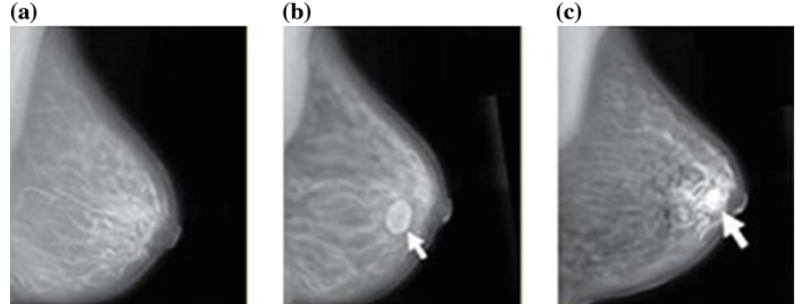
Figure 10. Breast cancer mammogram images from the DDSM dataset: ( a ) normal, ( b ) benign (not cancer), and ( c )